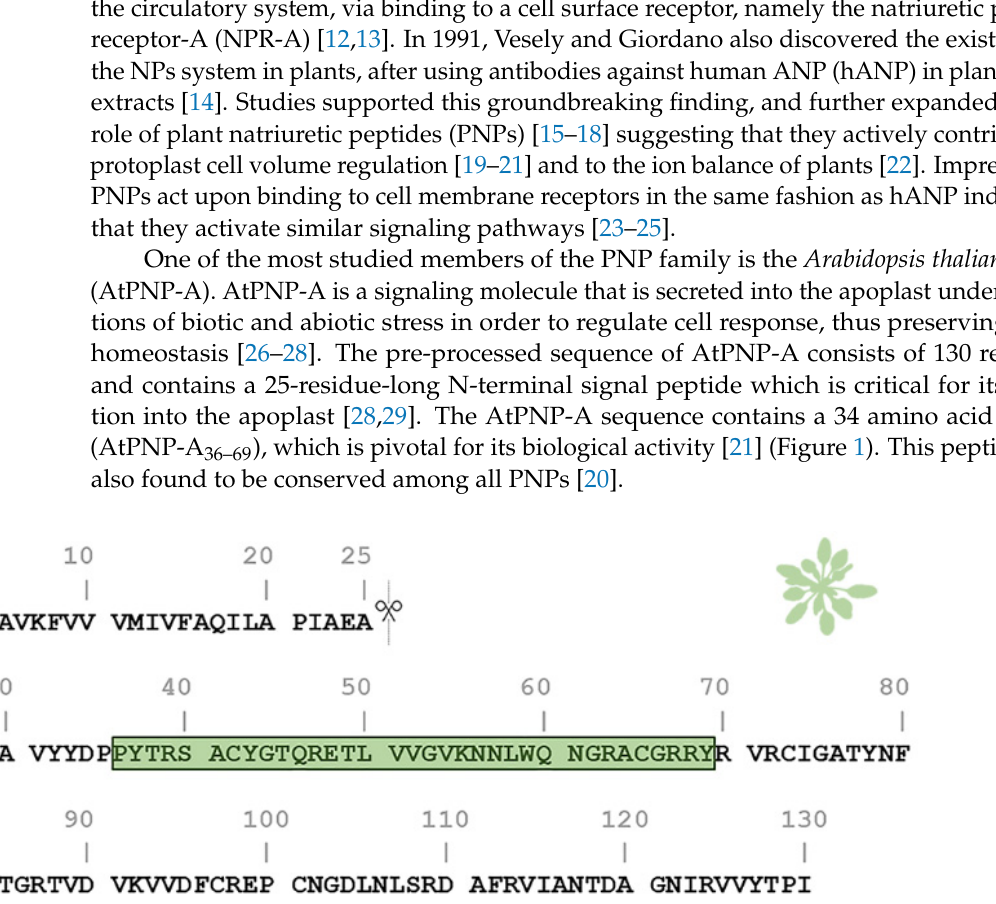
Figure 1. Amino acid sequence of the Arabidopsis thaliana plant natriuretic peptide (AtPNP-A). The pre-processed sequence of AtPNP-A (UniProt AC: Q9ZV52) consists of 130 residues and contains a signal peptide in its N-terminal (residues 1–25), responsible for its secretion. The active domain of the AtPNP-A molecule (AtPNP-A 36–69 ) corresponds to the 36–69 region (green box). In the early 2000s, Ludidi et al. suggested that the hANP displays a distant sequence homology (ca. 30%) with the 34aa active domain of AtPNP-A and presented their align- ment, based on their sequence similarity (Figure S1) [20,29]. The two proteins have a sim- ilar signaling pathways involved in ion balance and water movement regulation [13,22].